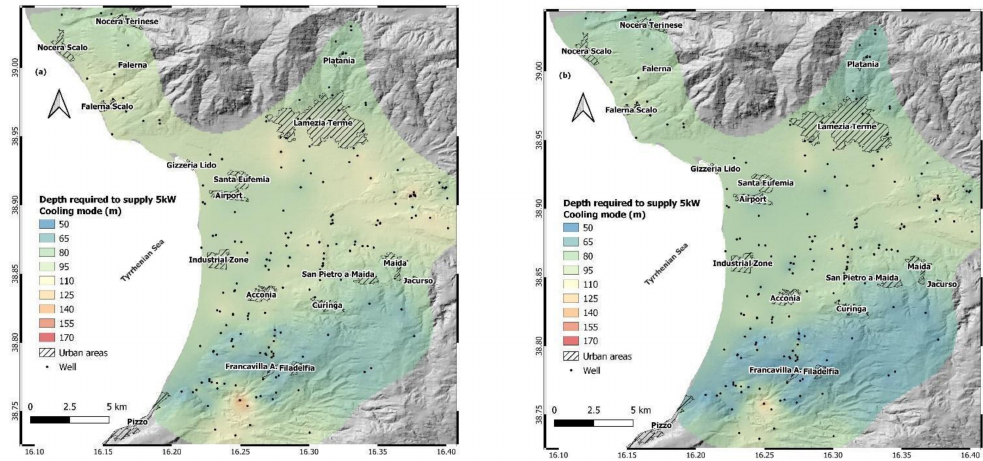
Figure 6. Map of the estimated depth to be drilled to supply a fixed domestic energy demand of 5.0 kW for space ( a ) heating and ( b ) cooling in the